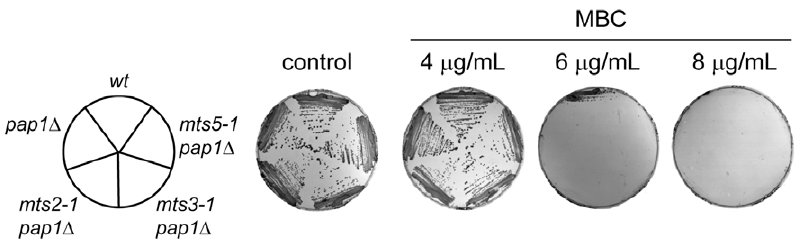
Figure 3. The multi-drug resistance of the mts mutants depends on Pap1. The indicated yeast strains (left panel) were streaked onto solid medium containing MBC at the shown concentrations and incubated for 48 hours at room temperature. On the control medium lacking drugs all the strains grew. In the presence of 6 m g/mL MBC some growth of the wild type was still apparent, while no growth of the other strains was observed. doi:10.1371/journal.pone.0050796.g003 resistance (Fig. 5a), suggesting that Rhp6 is involved in Pap1